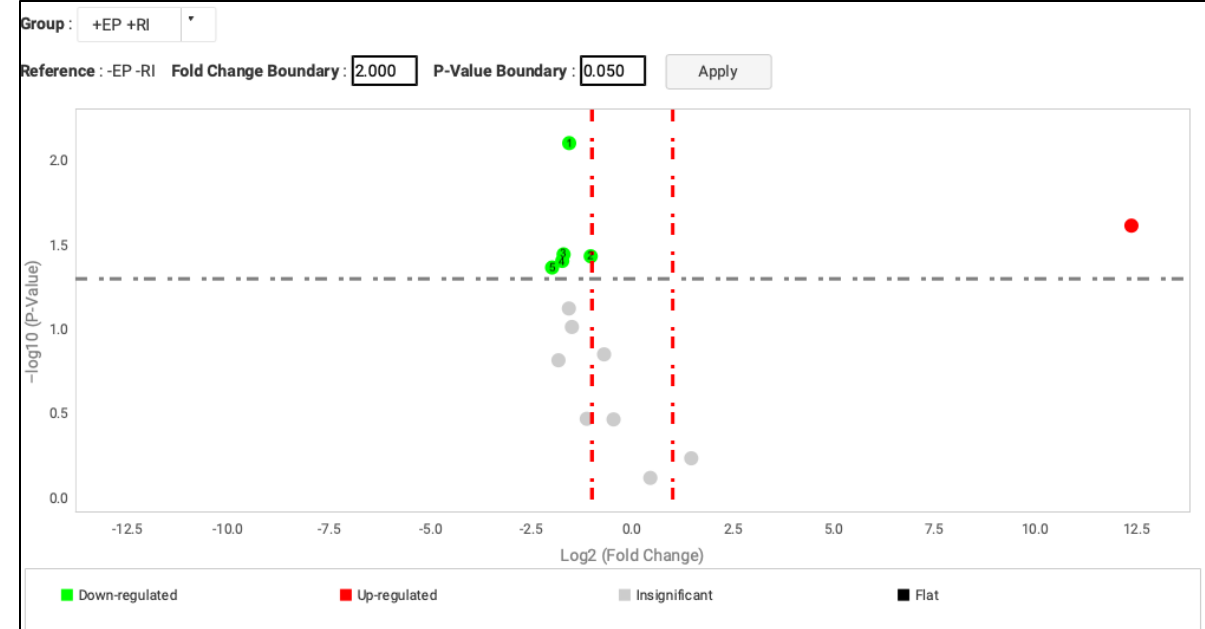
Figure 1. Volcano plot thermo image. Comparison of the results PD+RI+ vs. PD − RI − (statistical analysis using the t -test; fold change boundary: 2.000; p -value boundary: 0.05. MT1F 4 , MT1X 1 , MT1E 3 , MT2A 5 (downregulated genes), and HPTR1 2 (endogenous gen) are shown in green. The MT1M gene is highlighted in red. PD = EP (Spanish acronyms for periodontal disease).